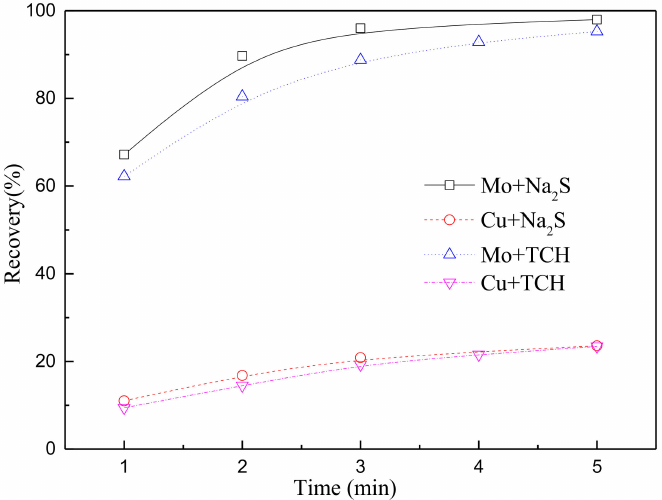
Figure 3. Flotation recovery of Cu and Mo at different flotation time with different